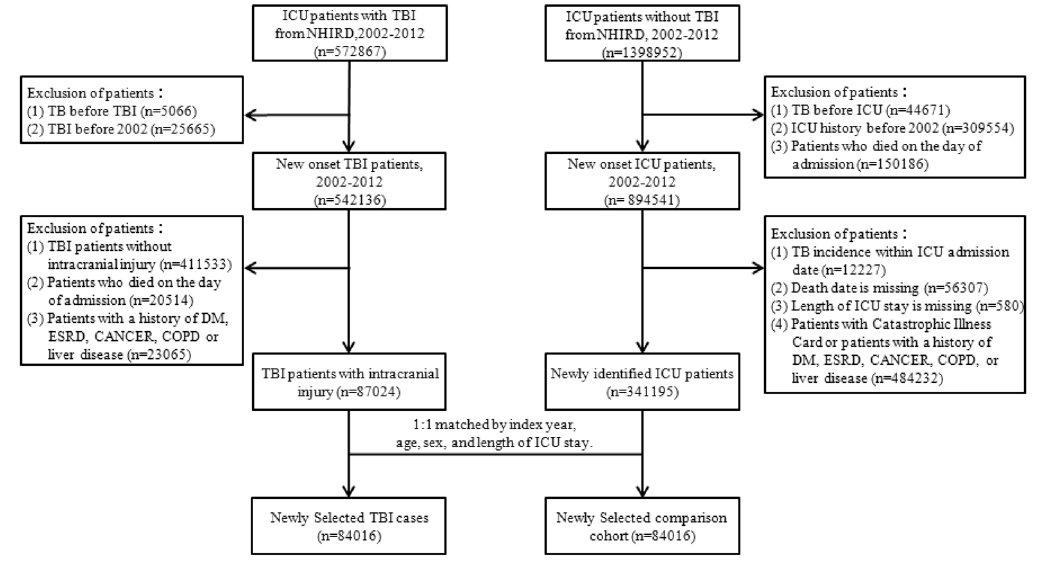
Figure 1. The flowchart for patients’